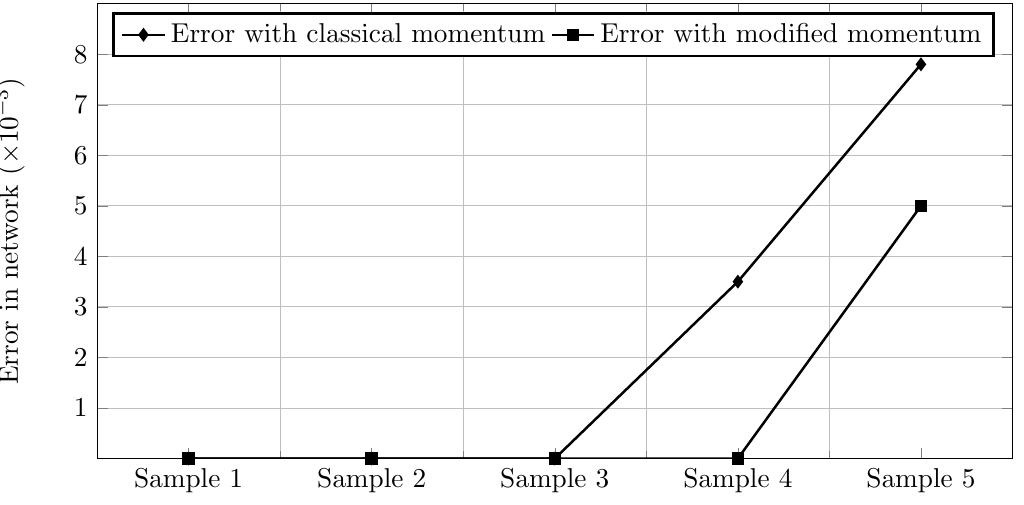
Figure 4: Comparison of the minimised error for the descent gradient and proposed conjugate descent